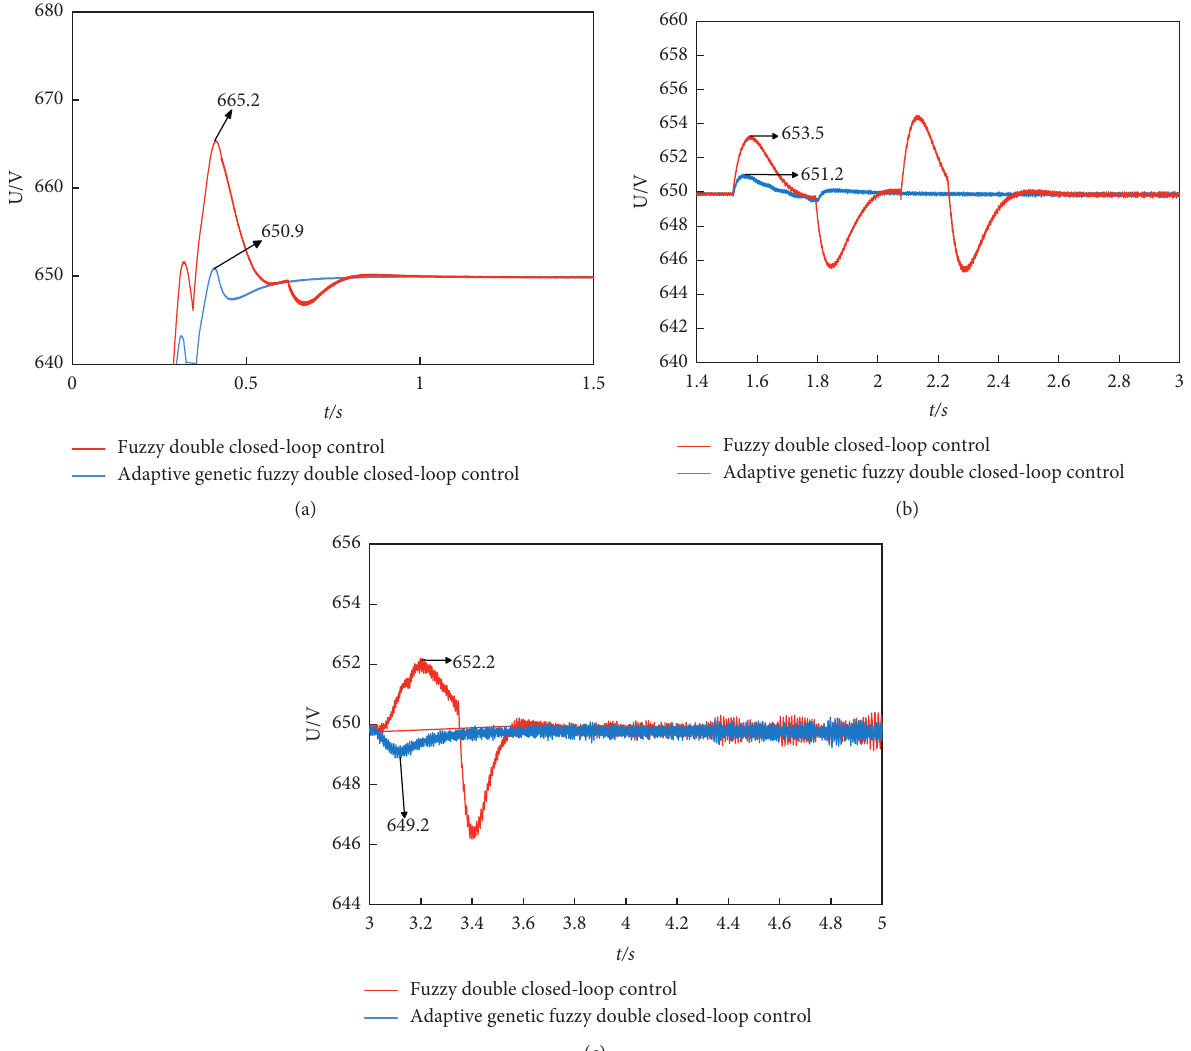
Figure 10: Voltage comparison of microgrid 2 bus. (a) Initial power-on. (b) Sudden increase of load. (c) A sudden drop in load.